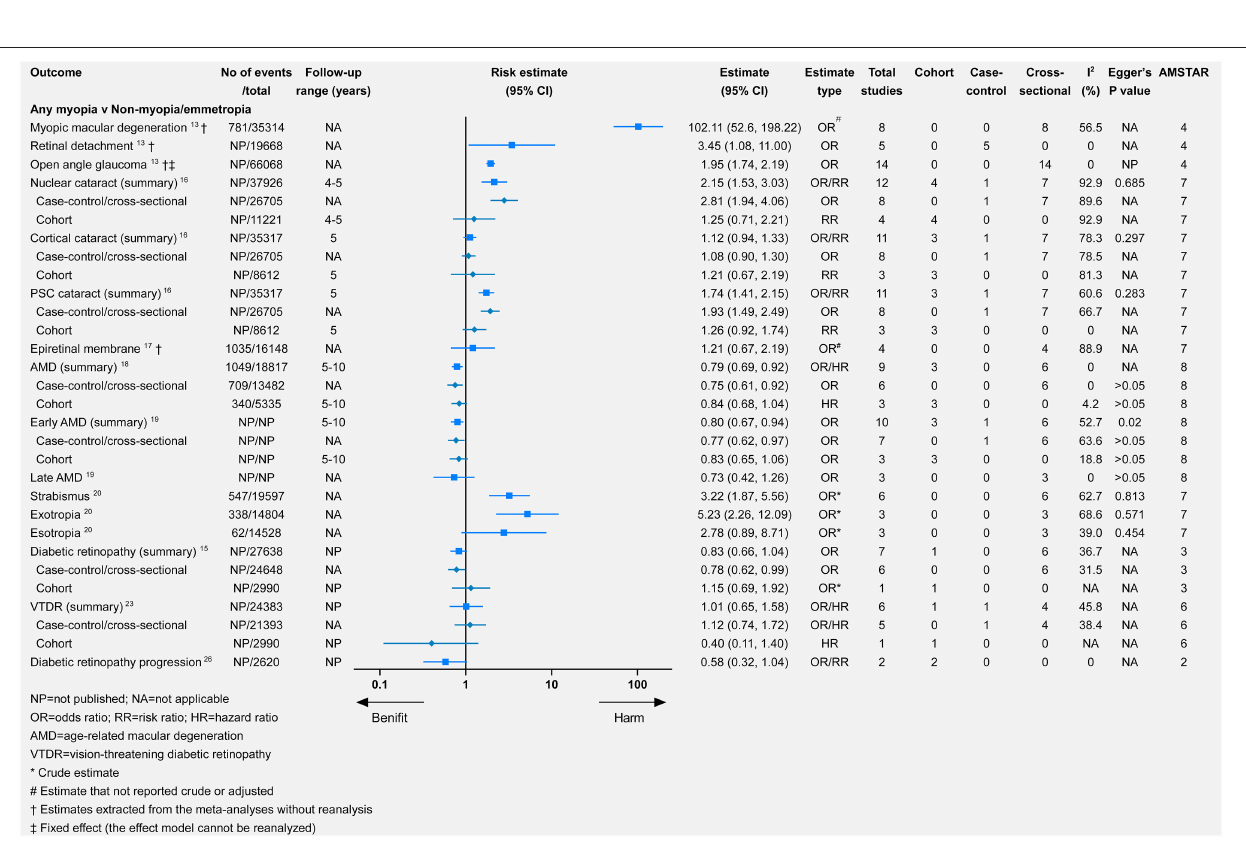
FIGURE 2 | Associations of any myopia with multiple eye health